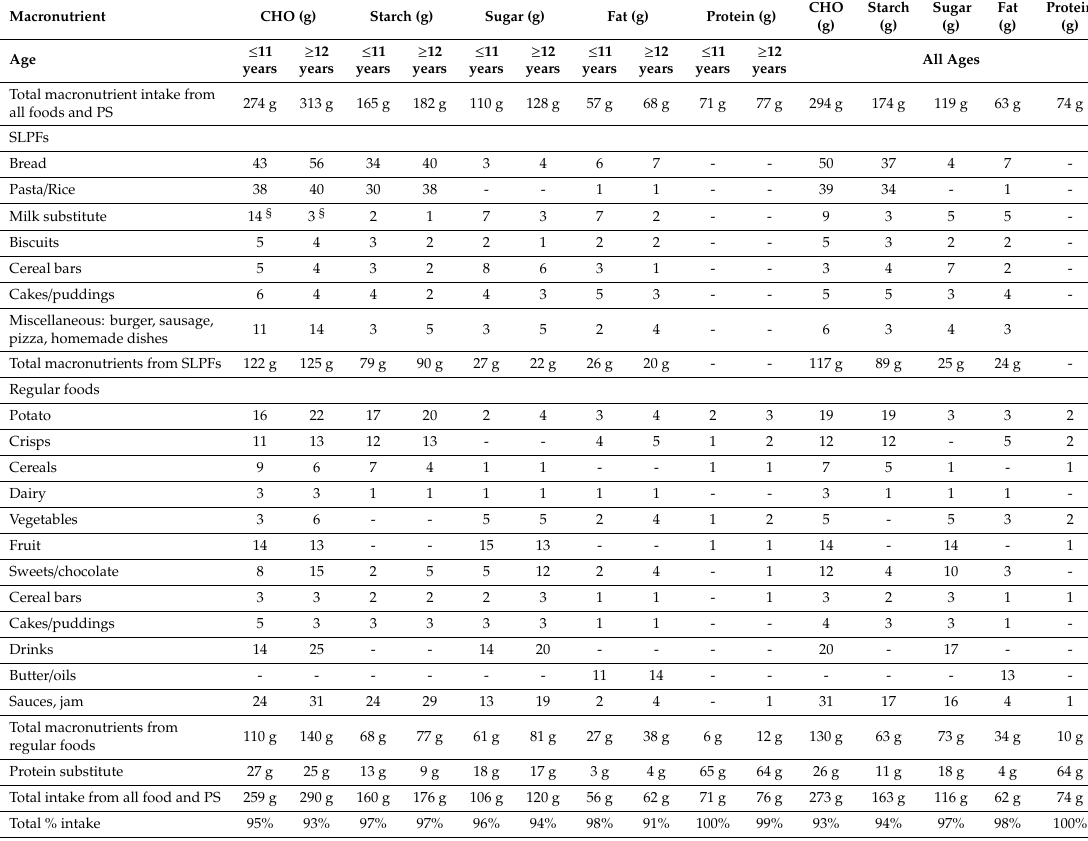
Table 3. Mean contribution of SLPFs, regular foods and protein substitute in grams to total carbohydrate, starch, sugar and protein intake for children with PKU.